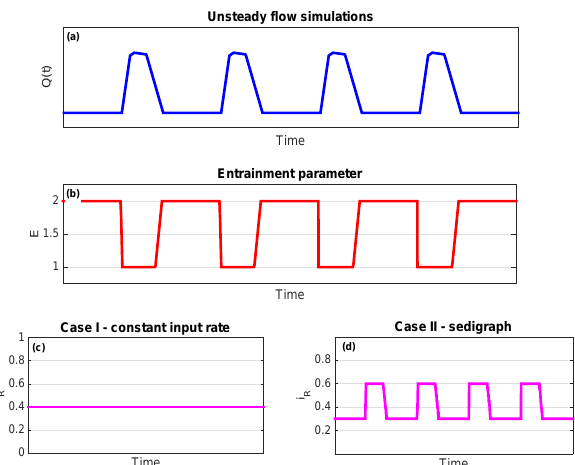
Figure 9. Unsteady simulations with four consecutive floods. (a) Generic hydrograph the model is simulating. (b) Variation in the entrainment parameter E to simulate the changing flow condi- tions. (c) Case I: simulations with varying E and constant input rate